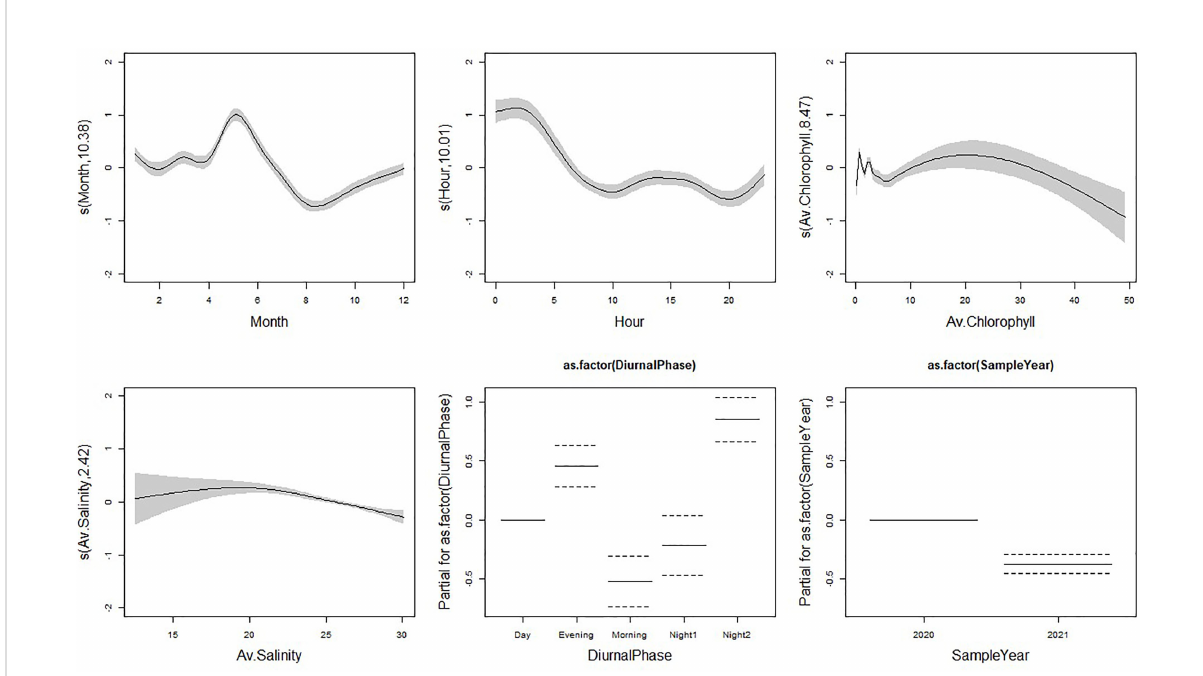
FIGURE 2 Fitted relationships for our F-POD Detection Positive Minutes (DPM) model based on GAM standard errors. 95% con fi dence intervals are represented by the grey areas around the relationship for each smooth covariate and as dotted lines for factor variables. The Y axis displays the partial residuals for each model covariate generated by regressing the response on the other covariates. A larger Y axis indicates a more important covariate for DPM of harbour porpoise.